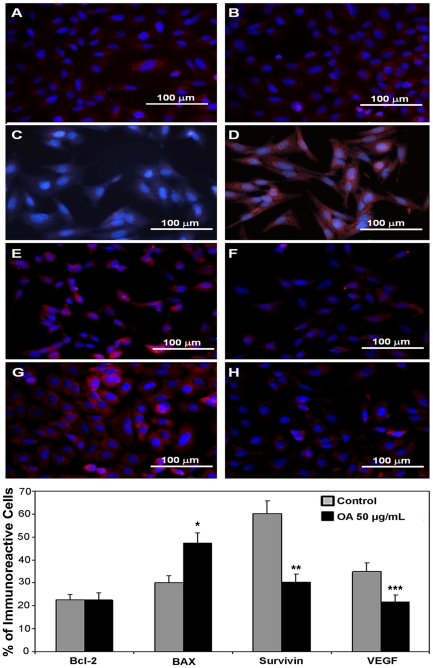
Effect of Oleanolic acid (OA) on proteins involved on apoptotic and metastatic pathways.
(Upper panel) Immunofluorescence of A549 cells stained for Bcl2 (A–B), Bax (C–D), survivin (E–F) and VEGF (G–H). A549 cells were treated with medium (A,C,E,G) or with 50 µg/mL OA (B, D, F, H) for 24 h, fixed, stained with the primary antibodies, revealed with biotinilated IgG followed by streptavidin-Cy3 and counter stained with DAPI, as described in M&M. Representative immunofluorescence micrographs of three experiments. Bar: 100 µm. (Lower panel) Graphical representation of the histomorphometrical results of the immunocytochemical assay. The percentage of immunoreactive cells was calculated from the DAPI positive cells. Bcl-2 was not modulated by OA (p>0.05), but Bax was significantly increased (* p<0.005), while survivin and VEGF were significantly decreased after treatment (**p<0.0001 and ***p<0.05, respectively).